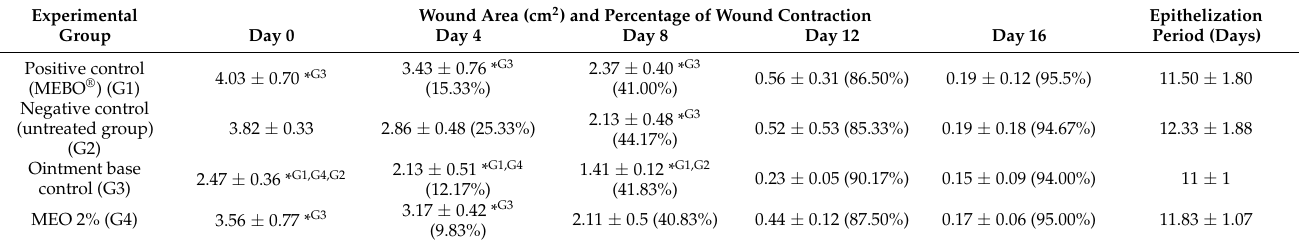
Table 4. Effect of topical treatment by MEO and standards on wound contraction after 16-day excision wound in rats.